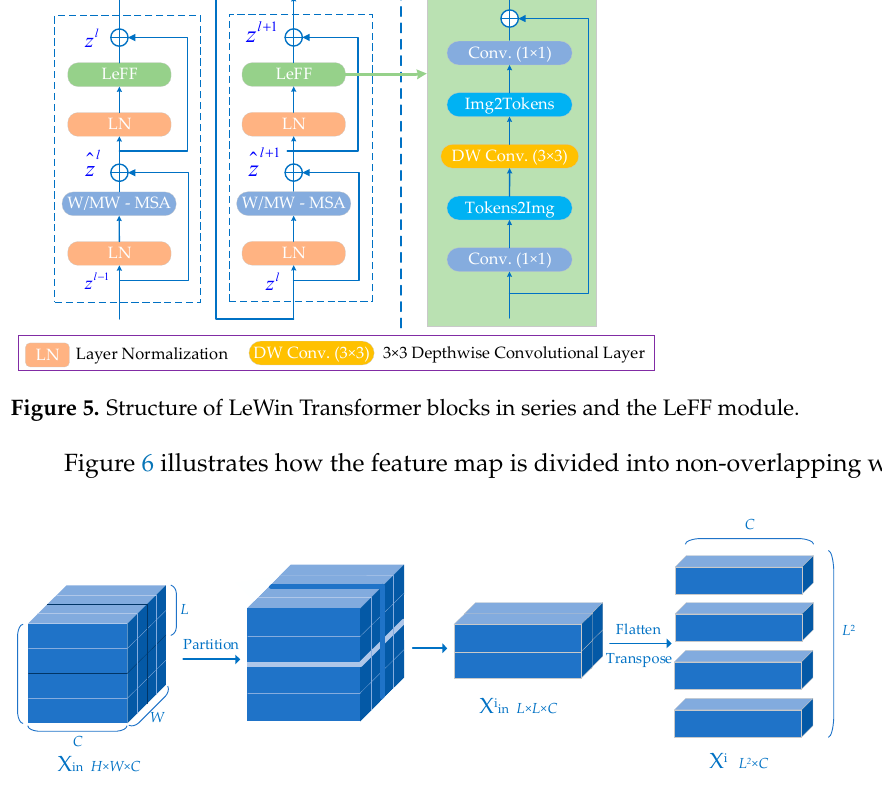
Figure 6. How the feature map is divided into non-overlapping windows.